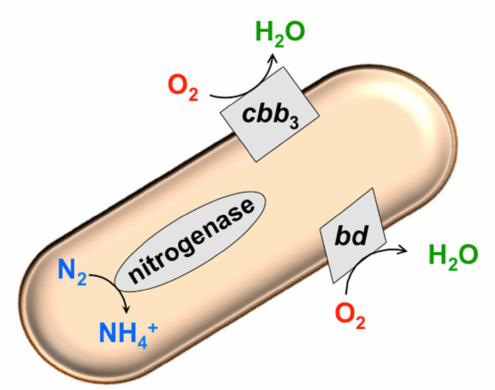
Figure 1. Cytochrome bd and cytochrome cbb 3 protect O 2 -labile nitrogenase from oxidative inactivation. 3. Bacterial Mutants Devoid of Cytochrome bd Show Higher Sensitivity to H 2 O 2